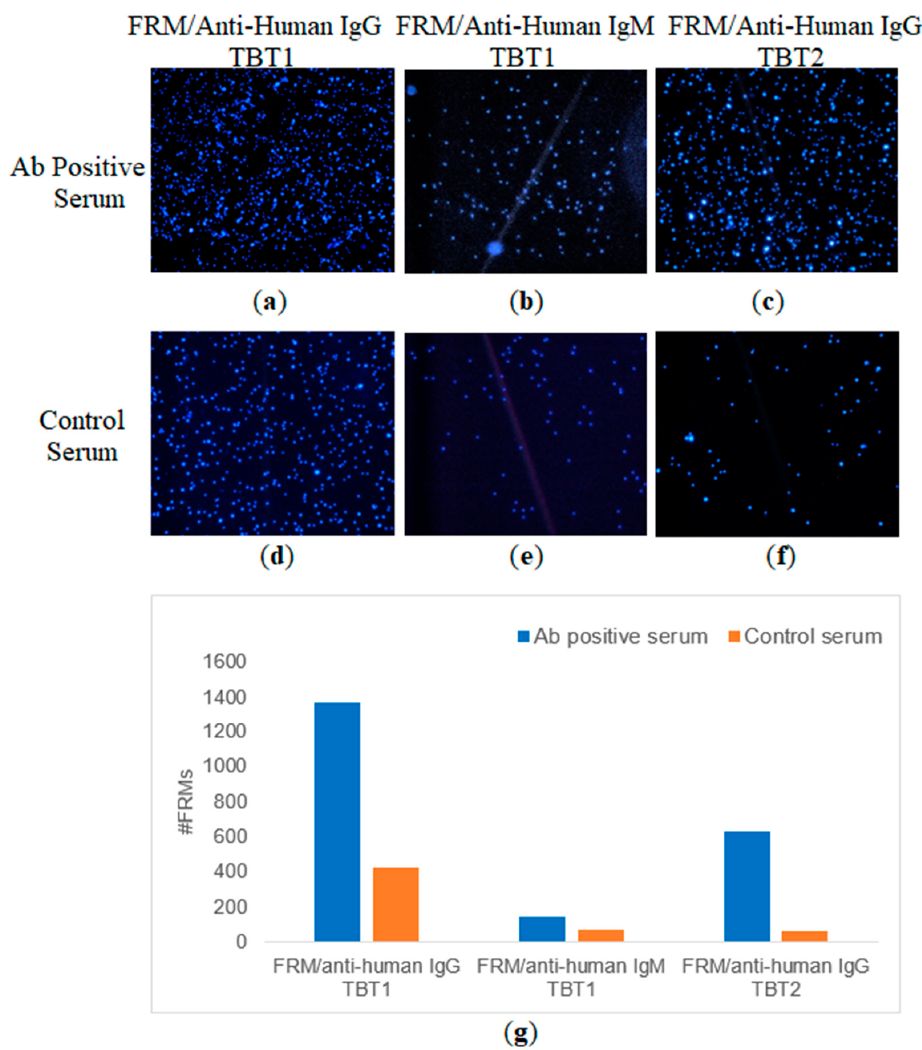
Figure 7. Blue, fluorescent images of the captured microspheres on the QCM surface after FRMs conjugated secondary antibody detection following Ab positive ( a – c ) and control serum ( d – f ) treatments. ( a , d ) are the results of FRM/anti-human IgG treatments, ( b , e ) are the results of FRM/anti-human IgM treatments for TBT1. Also, ( c , f ) are the results of FRM/anti-human IgG treatments for TBT2. ( g ) shows the number of FRMs captured on the QCM surface after various treatments for TBT1 and TBT2. The numbers of the FRMs captured on the QCM surface are 1368, 140, 631, 419, 72 and 58, which are shown in ( a – f ), respectively.